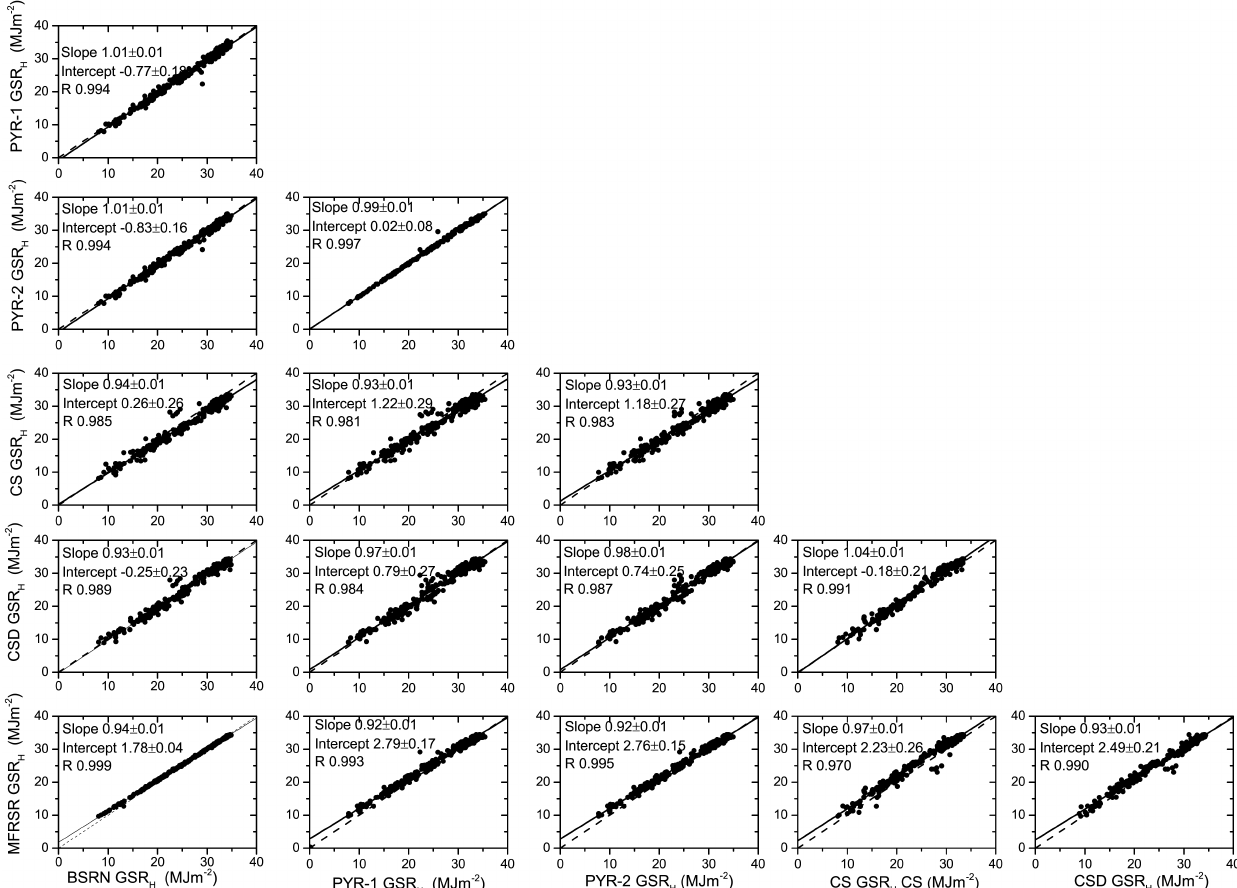
Figure 2. Scatterplot of daily GSR H (MJm − 2 ) performed with CM-21 (BSRN), pyranometer (PYR) determined from Method 1 (PYR-1) and Method 2 (PYR-2), CS recorder, CSD recorder and MFRSR radiometer between 17 July 2014 and July 2015 at IZO ( N = 272 days). The black solid lines are the least-squares fits and the dotted lines are the diagonals ( x = y) . The least-squares fit parameters are shown in the legend (slope, intercept and correlation coefficient R ). N : 272